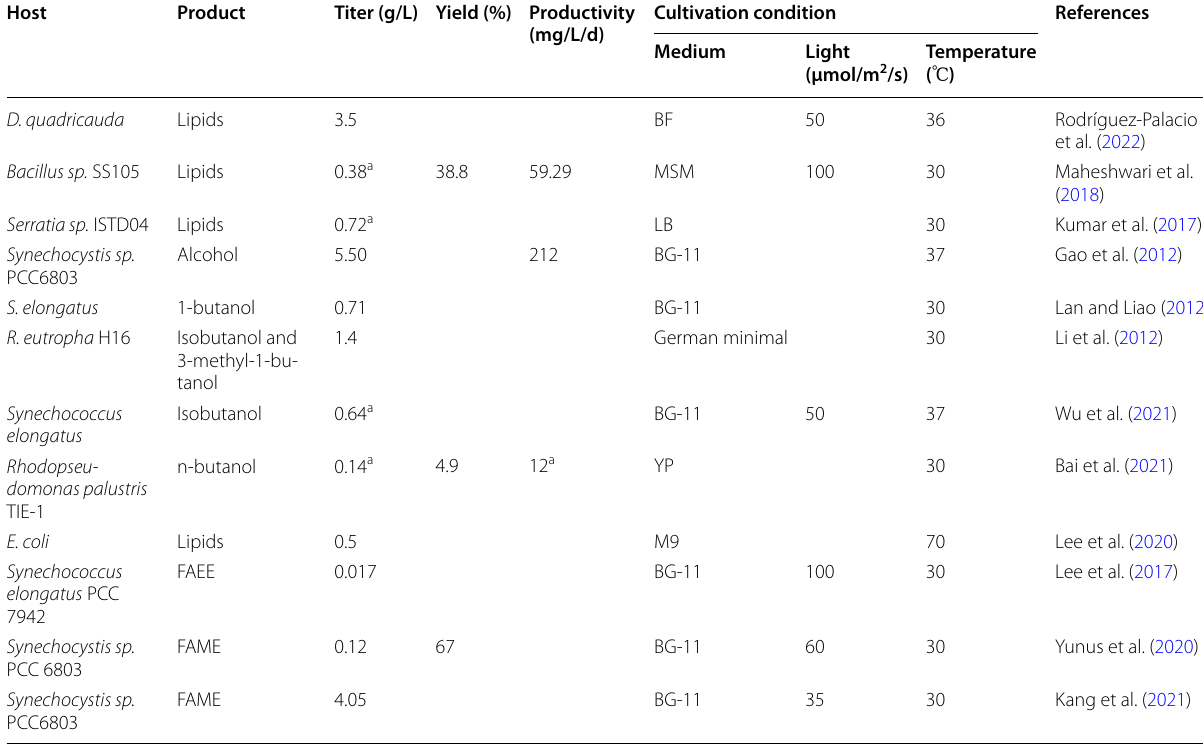
a The value is calculated based on the reported